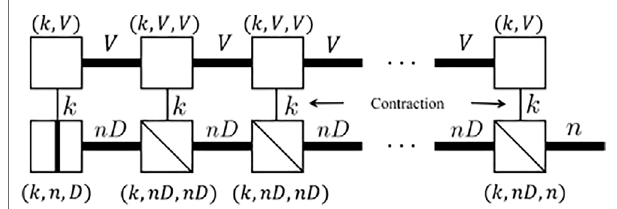
FIGURE 6 | Schematics of contractions between the core MPS 〈 C | (upper) and the batched MPS |( B , I j ) 〉 (down).